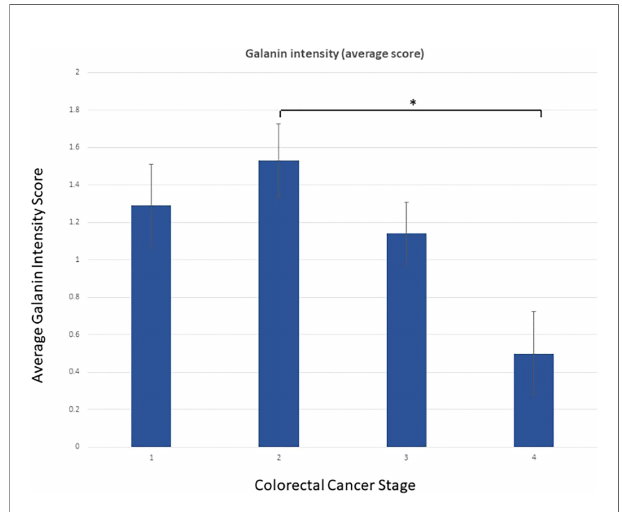
FIGURE 2 | Galanin intensity according to TNM staging. Galanin intensity is signi fi cantly lower in stage IV CRC compared to stage I-III (p= 0.037, using the non-parametric Mann-Whitney U test). * p-value